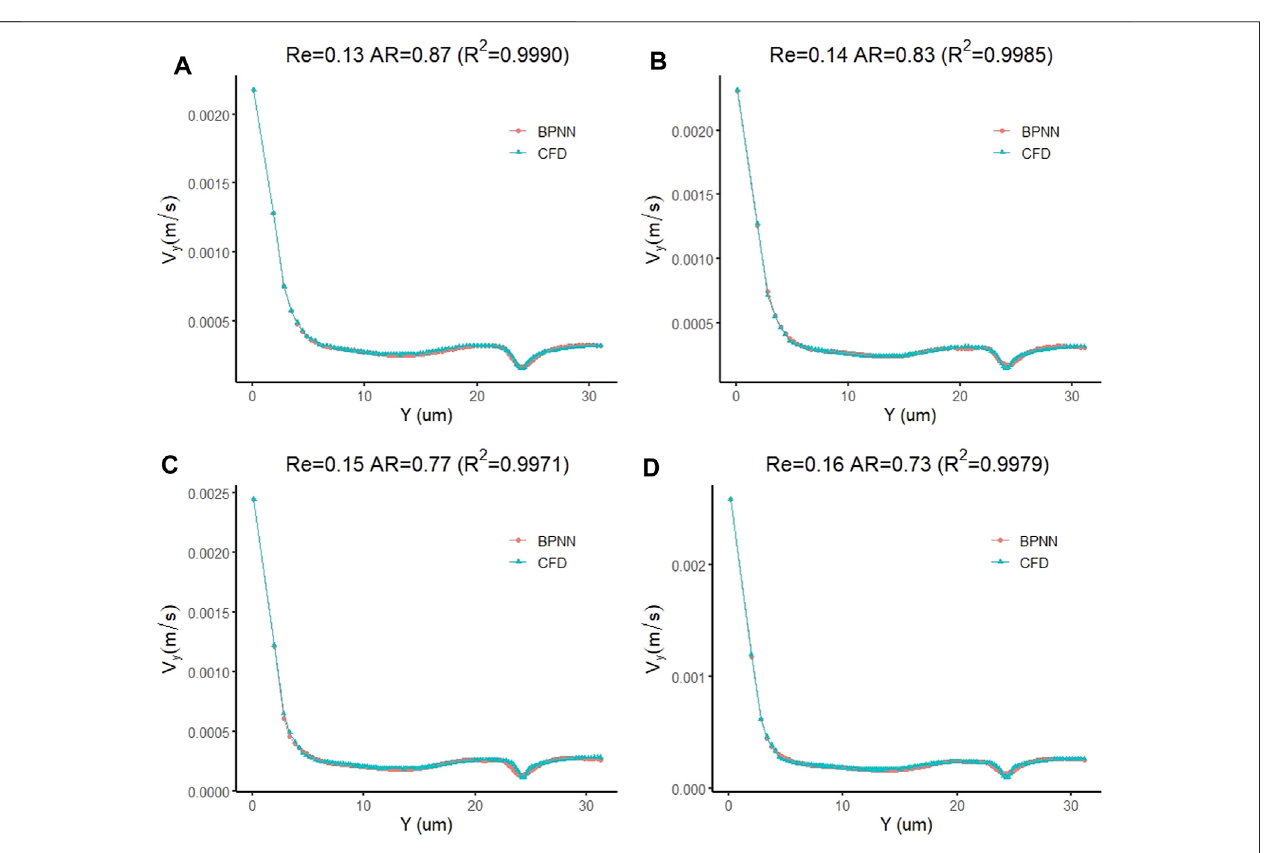
Frontiers in Bioengineering and Biotechnology |